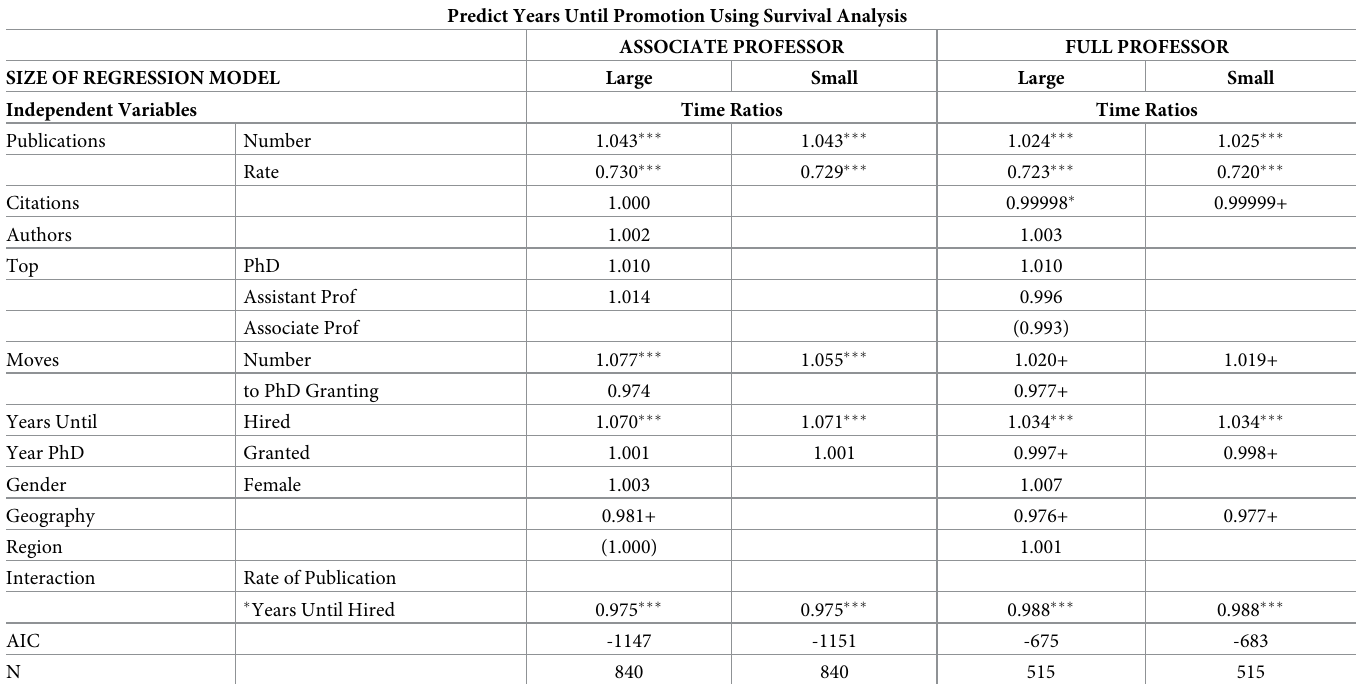
Table 5. Survival analysis time ratios of variables predicting years to promotion.